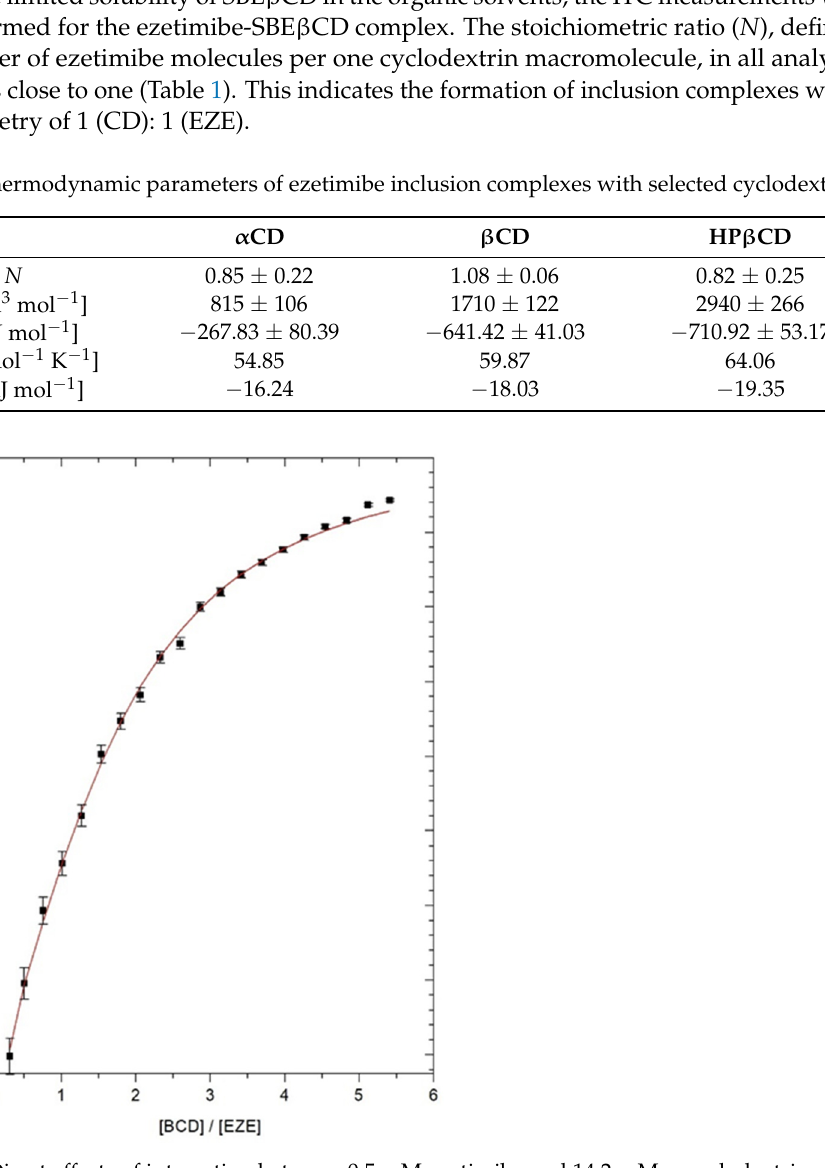
Figure 4. Direct effects of interaction between 0.5 mM ezetimibe and 8.52 mM HP- β -cyclodextrin. The obtained complex stability constants, for β CD and HP β CD complexes, have val- ues K > 1000 dm 3 mol − 1 . This confirms the formation of stable complexes between the ezetimibe and the molecules of these cyclodextrins. The enthalpy changes of the complex- ation processes of ezetimibe with all cyclodextrins are exothermic ( Δ H < 0) (Table 1). The changes in entropy for all studied systems take on positive values ( Δ S > 0) (Table 1), which proves the whole process of inclusion occurs spontaneously. Similarly, the changes in free